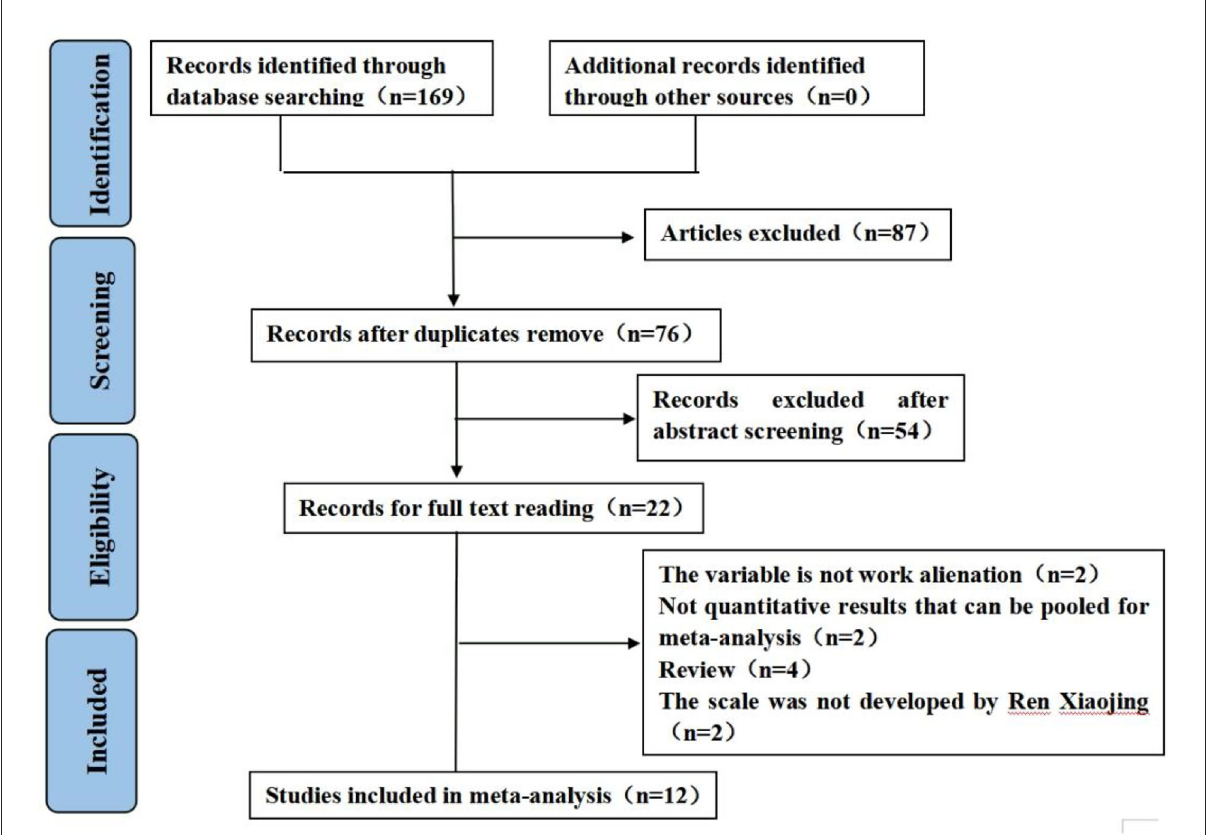
FIGURE1 Flowchart of included studies (PRISMA-2009-Flow-Diagram). From Page et al. (22). For more information, visit: http://www.prisma-statement.